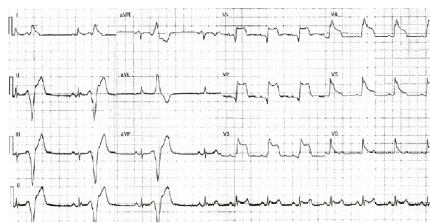
Figure 1: ECG showing ST elevation in the anterior leads while the patient was experiencing chest pain.